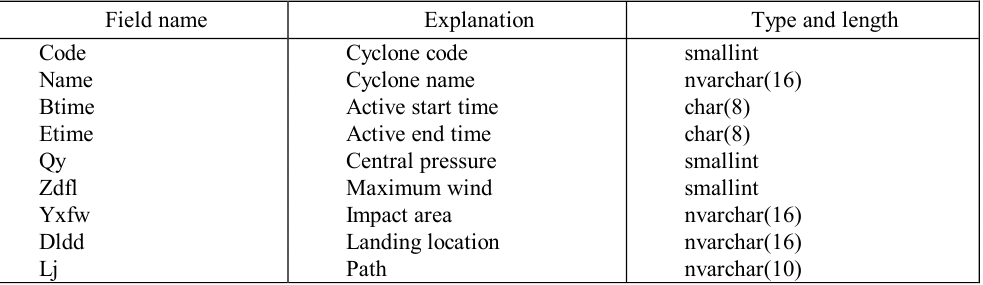
Table 3. The structure of tropical cyclone data